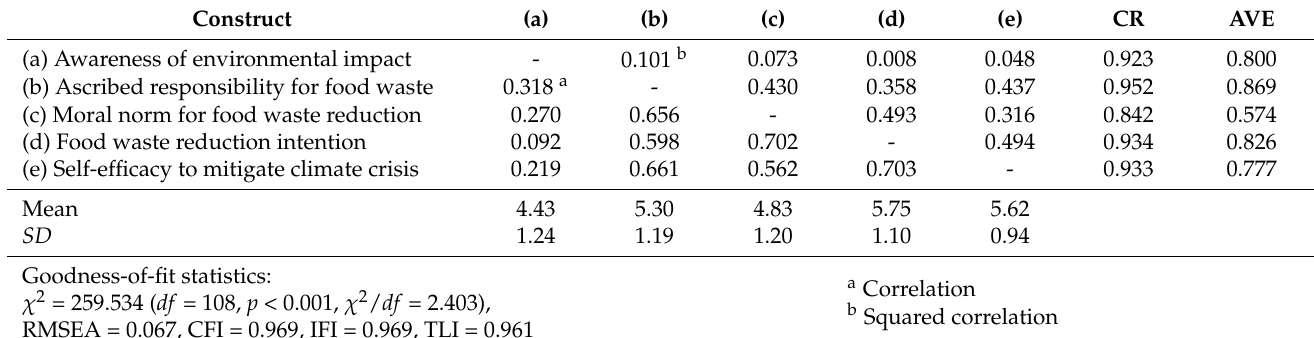
Table 2. Results of the confirmatory factor analysis and correlations ( n = 315).